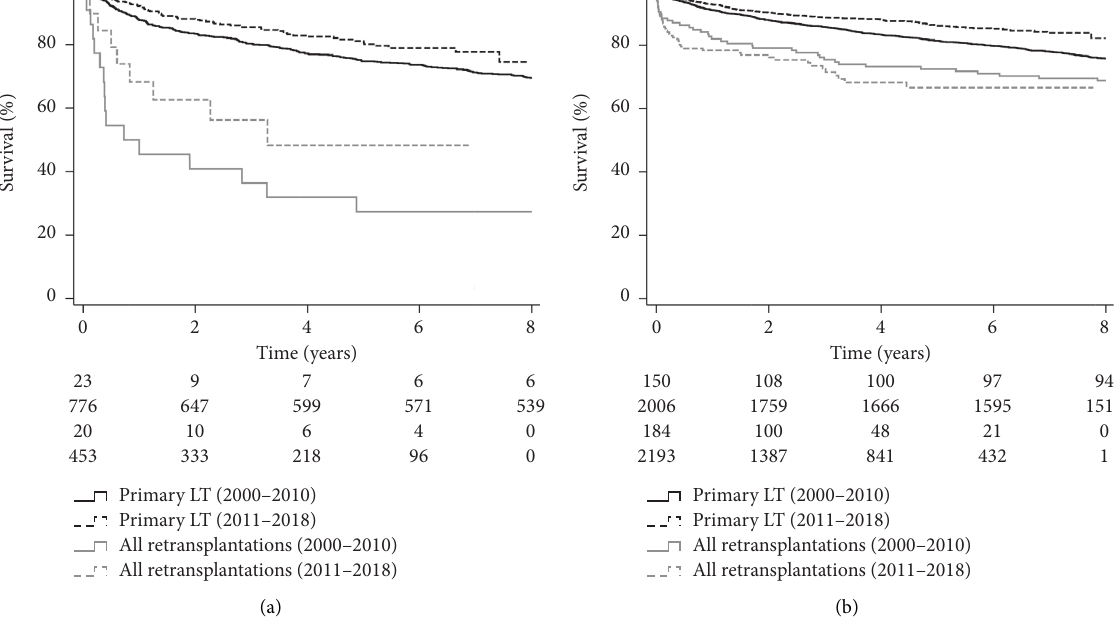
Figure 3: Temporal effects on post-transplant overall survival (pre-DAA era: 2000–2010 vs. post-DAA era: 2011–2018) (DAA: direct-acting antiviral agents; LT: liver